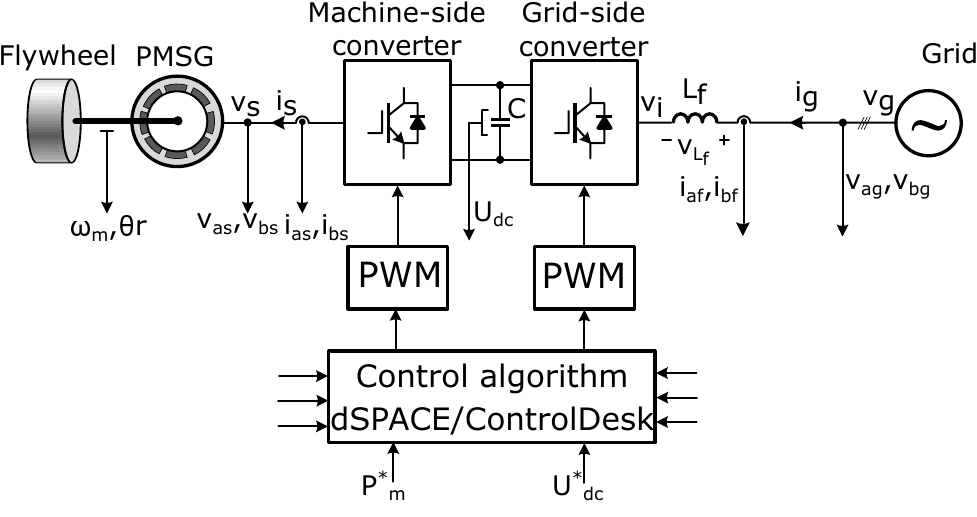
Figure 6. Flywheel general